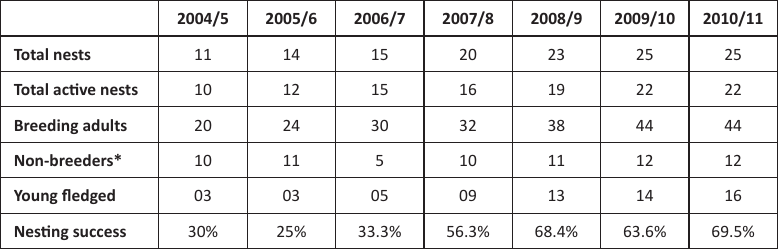
Table 1. The population of Oriental White-rumped Vultures Gyps bengalensis from the year 2004 to 2011 in Raigad District, Maharashtra. It shows breeding adults, non-breeding birds and newly fledged birds, with total numbers of nests and active nests. * Non-breeders include sub-adults and